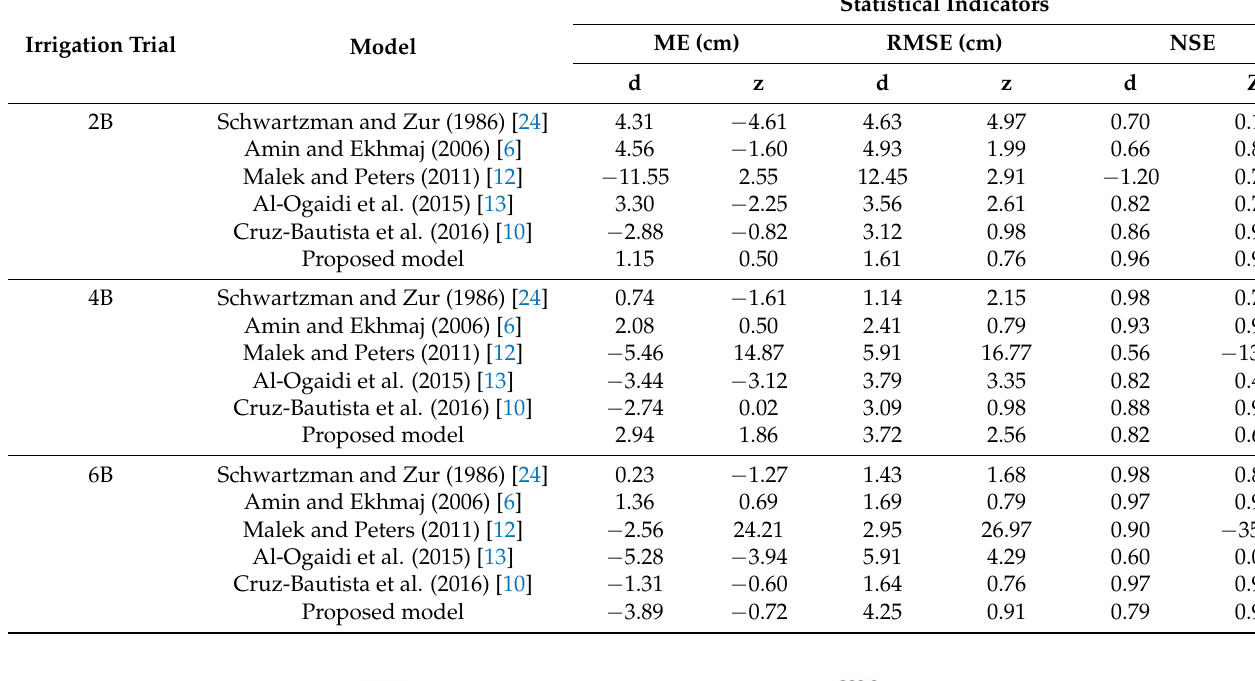
Table 8. Statistical indicators of the empirical models for the second irrigation block, with an emitter discharge rate of 3 L h − 1 , for the width (d) and depth of the wetting front (z).